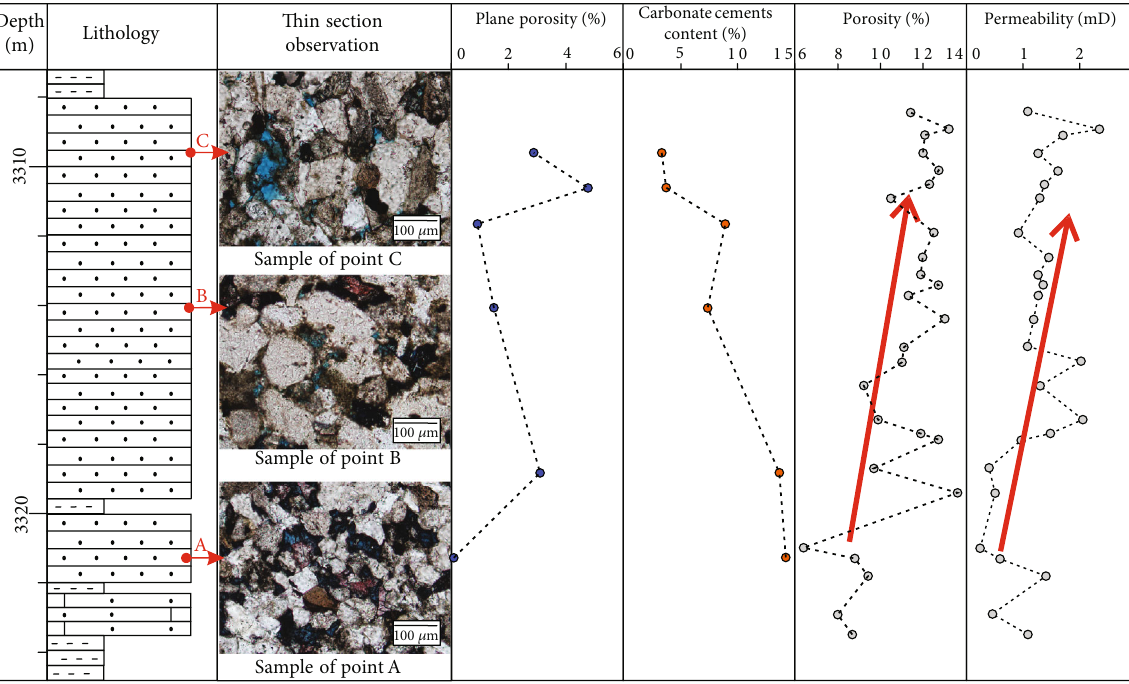
Figure 21: Vertical distribution of plane porosity and carbonate content of thin sections, porosity, and permeability in the F1 well in the Boxing Sag. Point A: all intergranular pores are destroyed by strong carbonate cementation; point B: a small amount of intergranular pores and carbonate cements; point C: intergranular pores are relatively